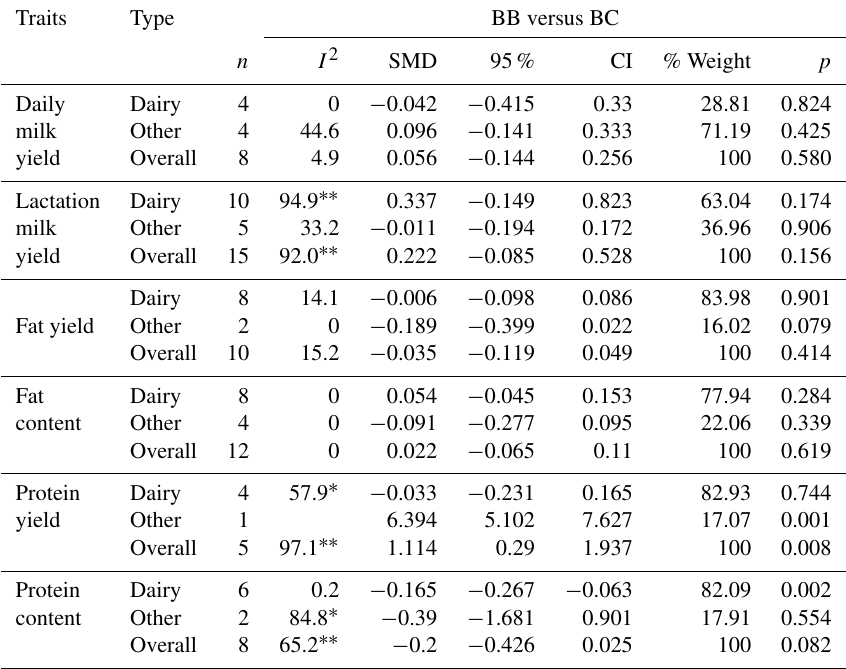
Table 5. Results of the meta-analysis on associations among CSN1S1 genotypes and milk production traits, SMD values, and level of